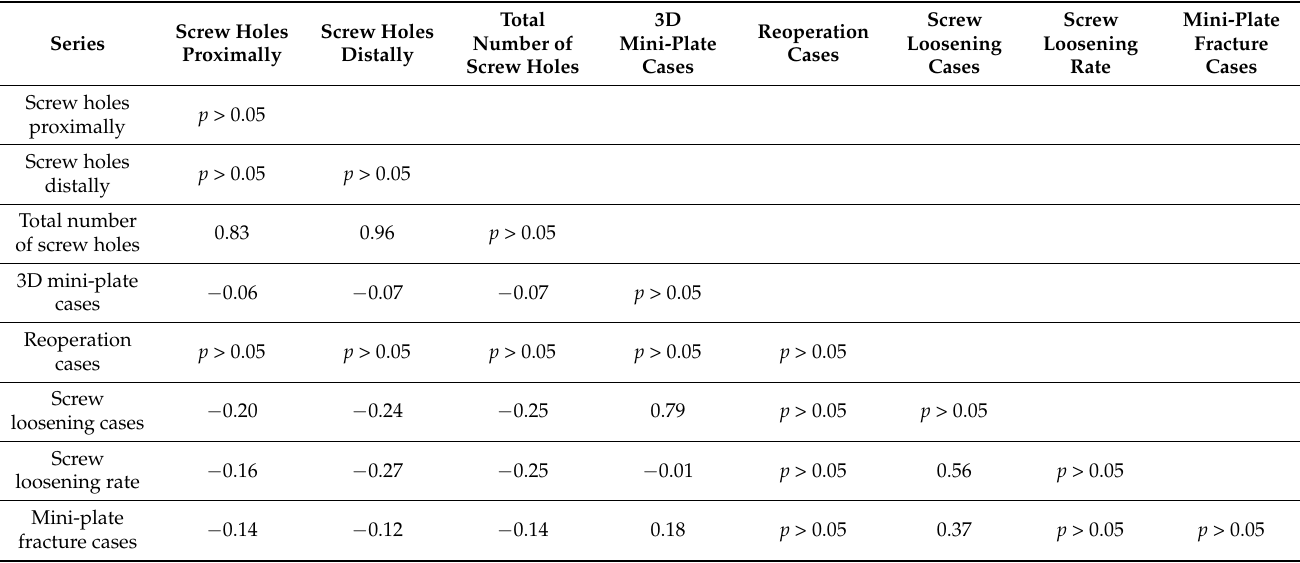
Table 5. Correlation matrix between numerical values from scientific research in a meta-analysis. Correlation values for data series where Student’s t -test showed p > 0.05 are not reported. Strong correlations, i.e., with an absolute value greater than 0.5.